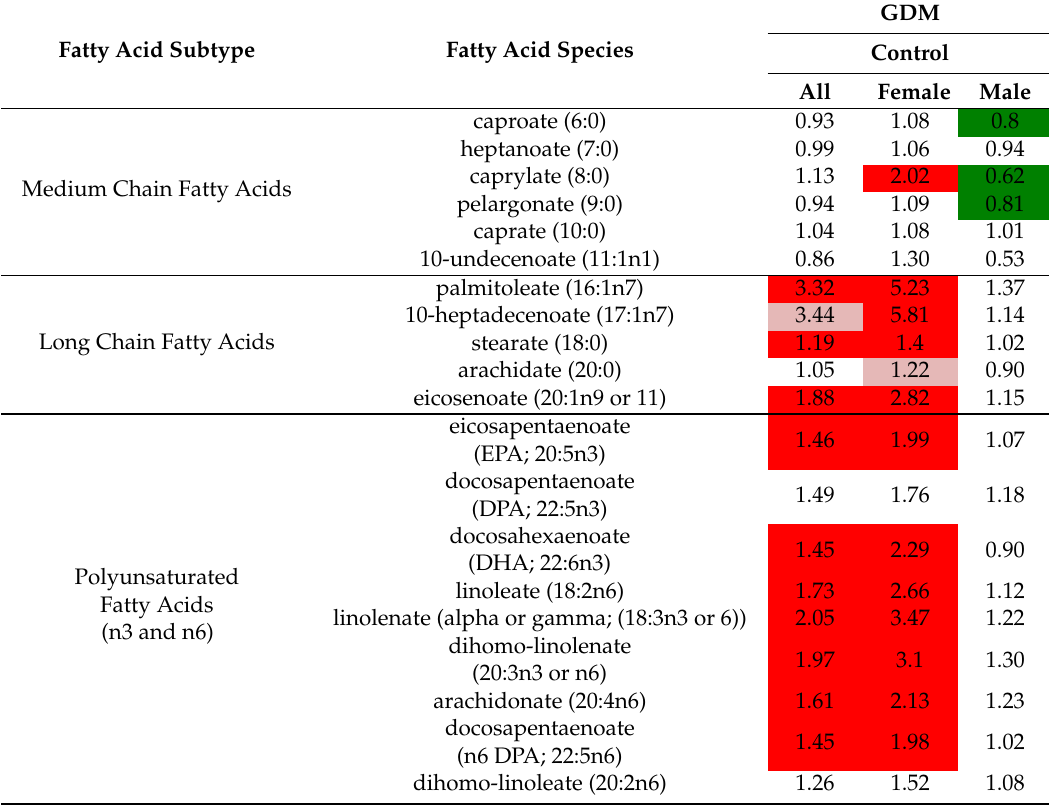
Table 5. Fatty acid subtypes in second trimester AF from women with